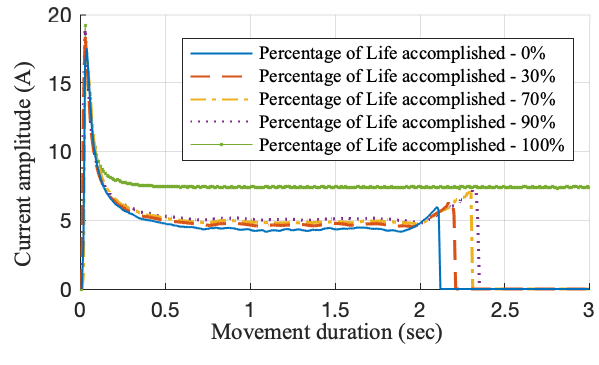
Figure 4. Current waveforms at different degradation